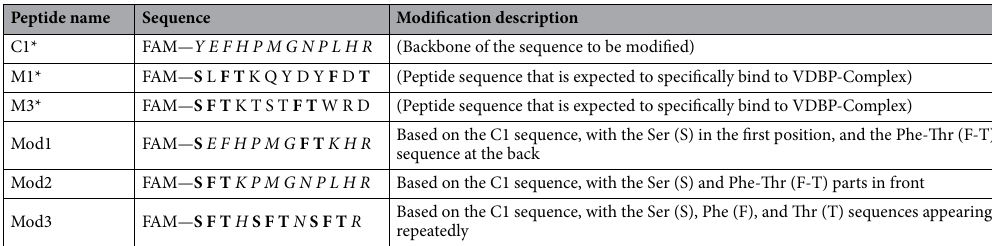
Table 5. Peptide sequences modification: SFT (Ser-Phe-Thr) motifs using C1 as the backbone for checking characteristic. FAM labeling modification is to calculate the amount of the peptide immobilized on the magnetic beads using fluorometer. * indicates control-specific (C1) and target-specific (M1, M3) sequences obtained through biopanning. No modification other than FAM labeling at the n-terminus was performed. Mod1, Mod2, and Mod3 sequences were modified based on the C1 sequence. Significant values are in bold.